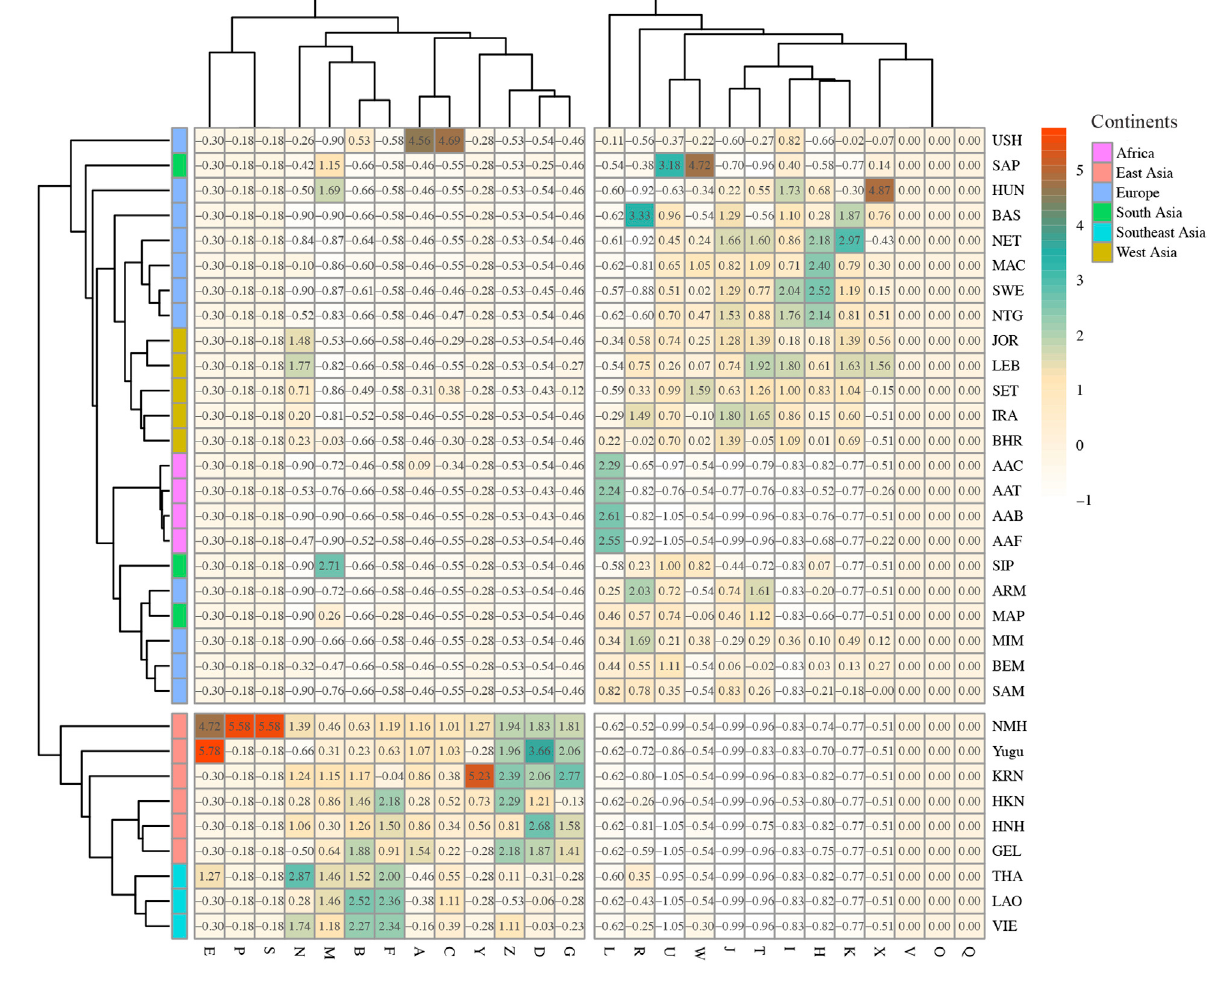
Frontiers in Genetics |